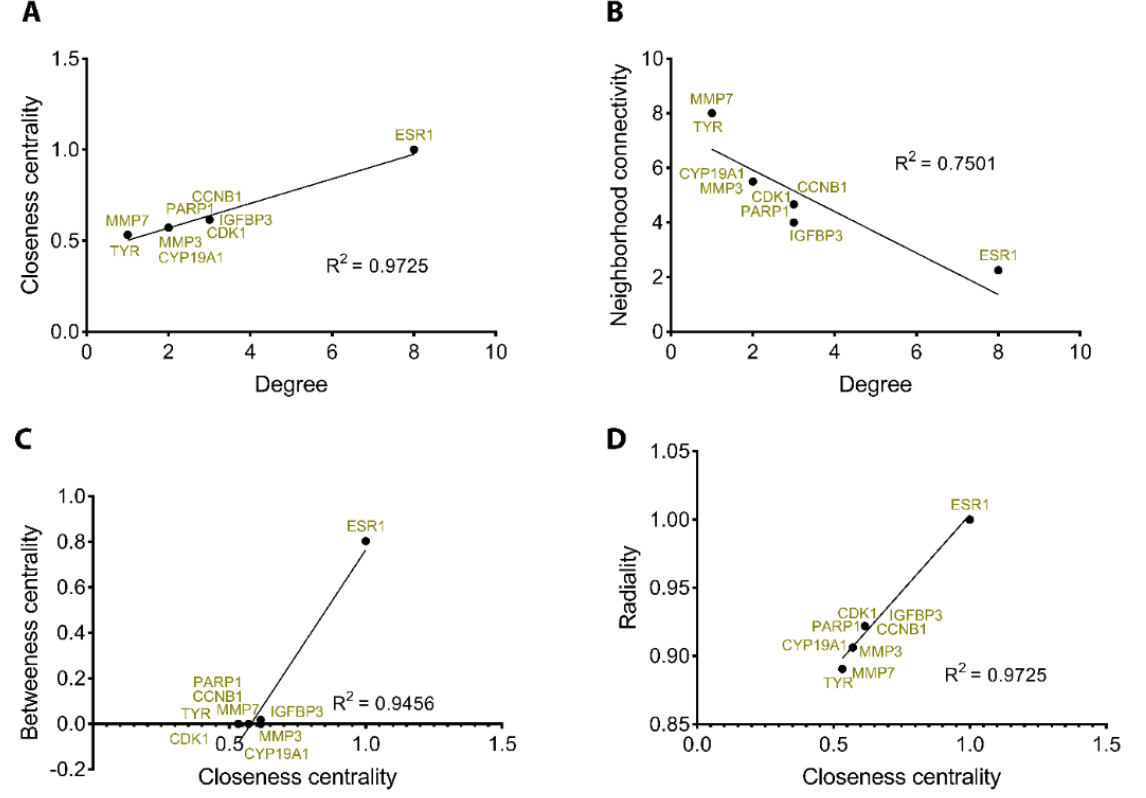
Figure 6. Validation of cellular hubs using Pearson’s correlation. ESR1 is a key molecular hub, positioning ahead of the other clustered proteins when closeness vs. degree ( A ), neighborhood vs. degree ( B ), closeness vs. betweenness ( C ), and closeness vs. radiality ( D ) are assessed in terms of functional correlation.